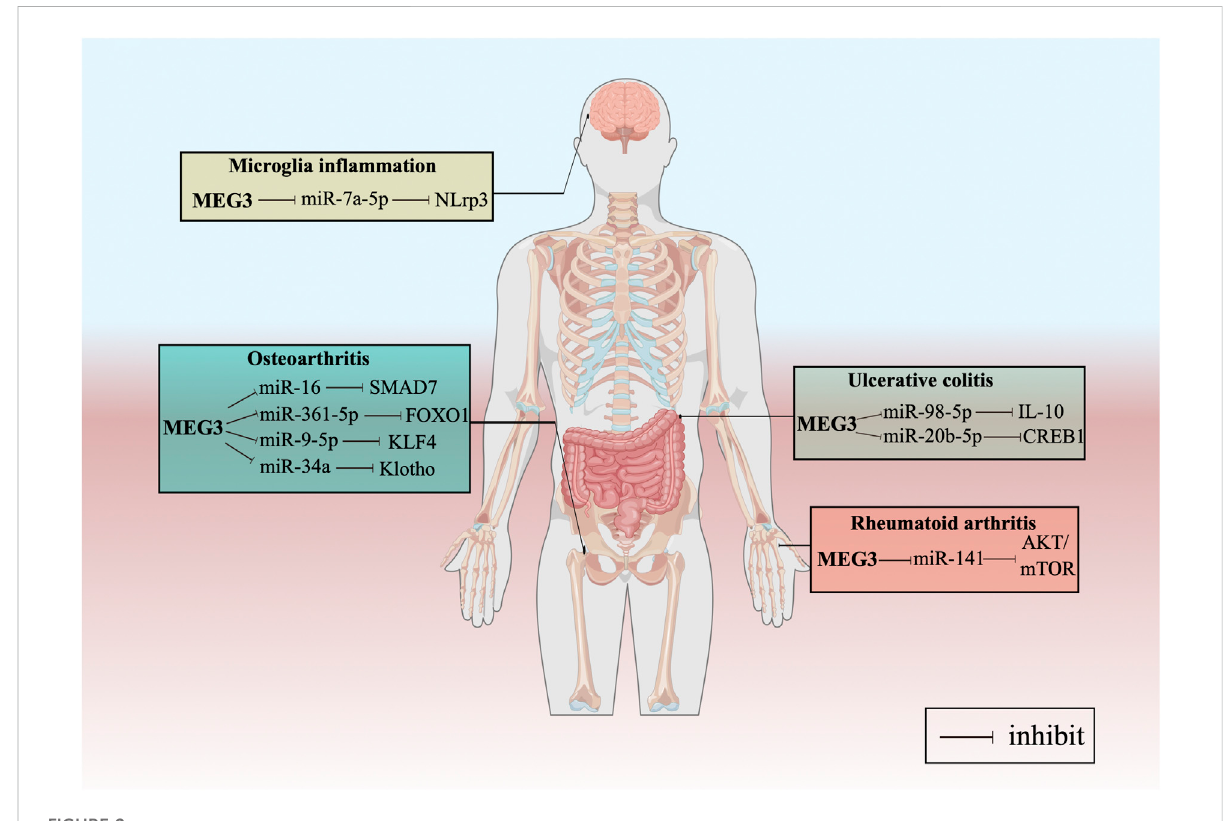
FIGURE 2 MEG3 mediates mechanisms involved in various common in fl ammatory